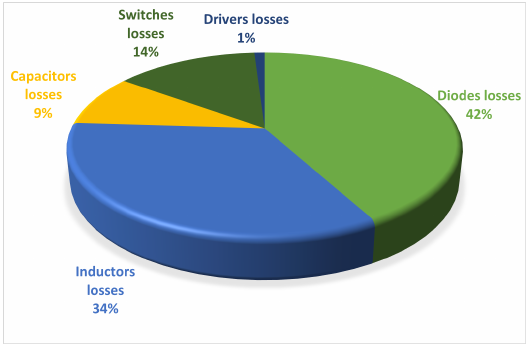
Figure 18. Pie chart of loss breakdown at nominal